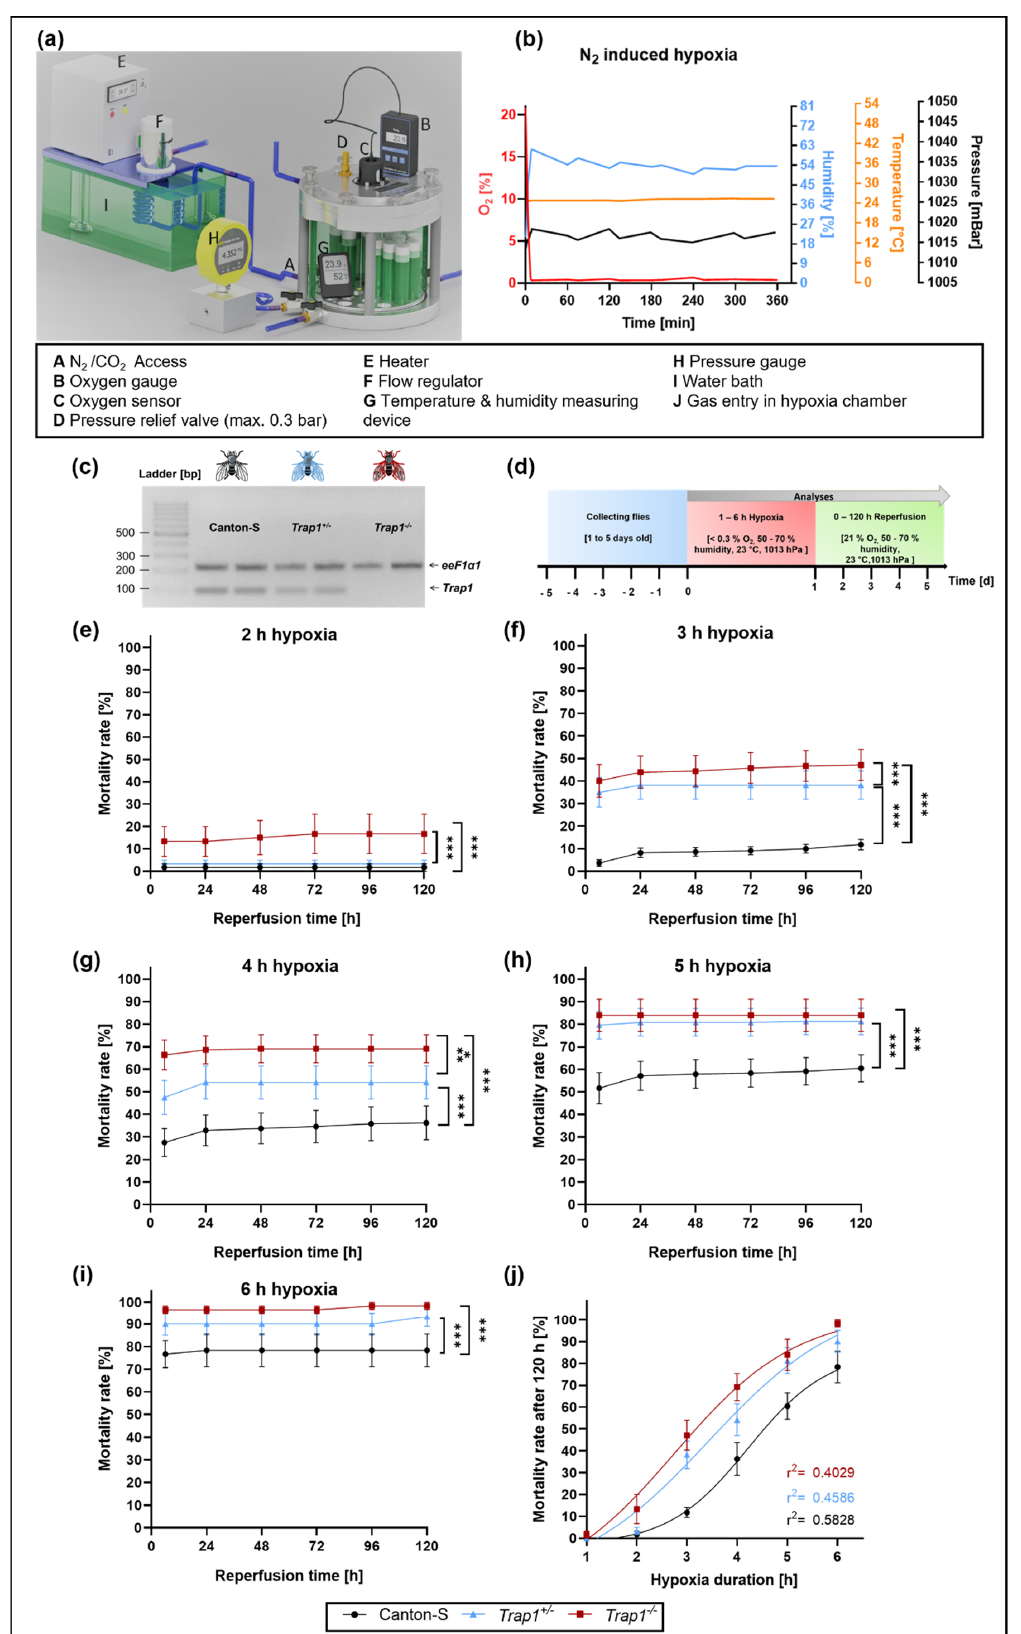
Figure 1. Mortality rates of Canton-S, Trap1 +/ − and Trap1 − / − flies subjected to different durations of monitored N 2